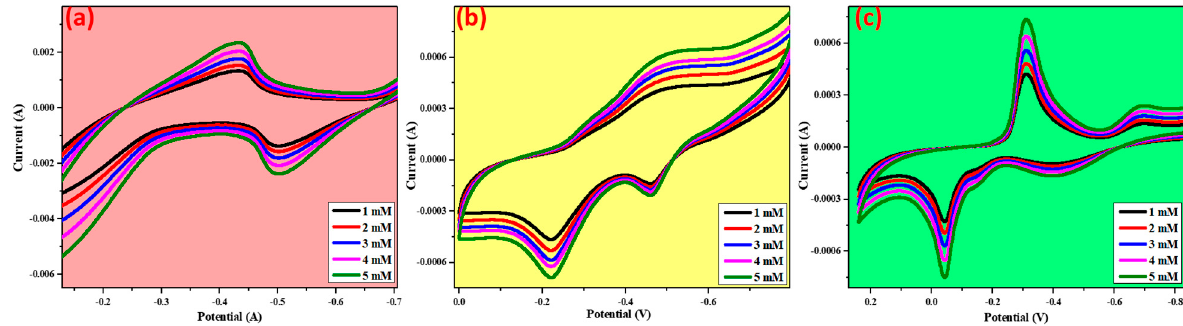
Figure 12. Glucose sensing for the prepared metal oxides by cyclic voltametric studies, ( a ) NiO, ( b ) CuO, ( c ) ZnO.